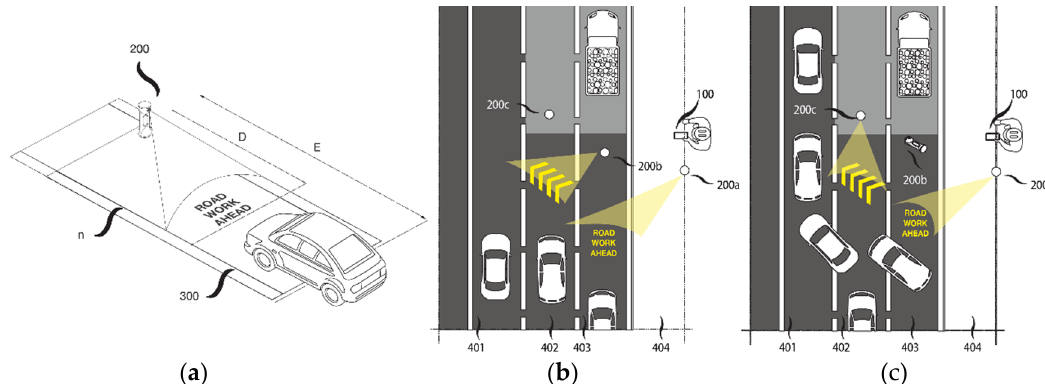
Figure 10. An example view explaining the vehicle guidance system: ( a ) vehicle guidance method between the robot device (200) and vehicle (300). D is the distance between the robot device and vehicle and E is the preset range; ( b ) in normal communication among 200a, 200b and 200c; ( c ) communication between 200a and 200c is available even when the robot 200b is damaged.